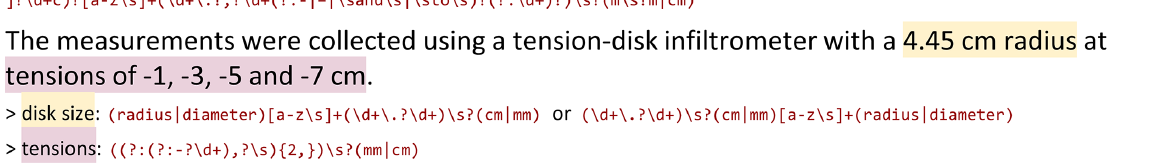
Figure 1. Examples of different regular expressions used for information extraction. \ d represents a digit, \ s a space, . (a dot) an unspecified character, and [a–z] all lower case letters, and more generally squared brackets are used to denote the list of characters (e.g., [ ◦∗ o0] is used to catch the symbol for degrees in latitude and longitude). A character can be “present once or absent” ( \ d \ . \ d? will match both integers and decimal numbers), “present at least once” ( \ d+ will match 7, 73 and 735) or “present at given number of times” ( \ d{1,2} will match 7 and 73 but not 735). Parentheses are used to segment capturing groups and can also contain Boolean operator such as OR denoted by | which is used to catch exact WRB soil names (Luvisol | Cambisol | etc.). Non-capturing parentheses are denoted with (?:) like for the regular expression of tensions. The content inside non-capturing parentheses will not be outputted as results of the regular expression in contrast to other parenthesis